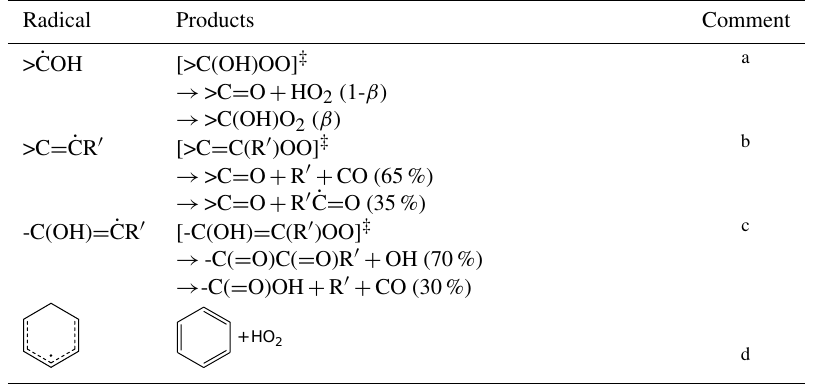
Table 15. Prompt rearrangements of chemically activated [ROO] ‡ adducts, formed from the reactions of organic radicals with O 2 . Radical Products